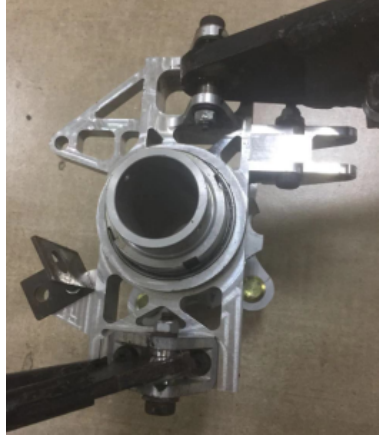
Figure 20. Manufactured part.